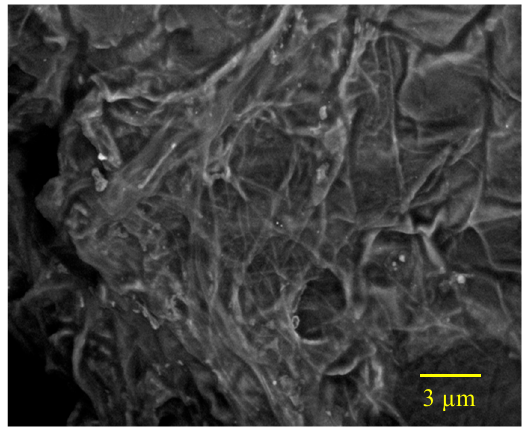
Figure 1. Typical SEM image of 3D graphene/PDMS with 1 mg/mL CNTs.